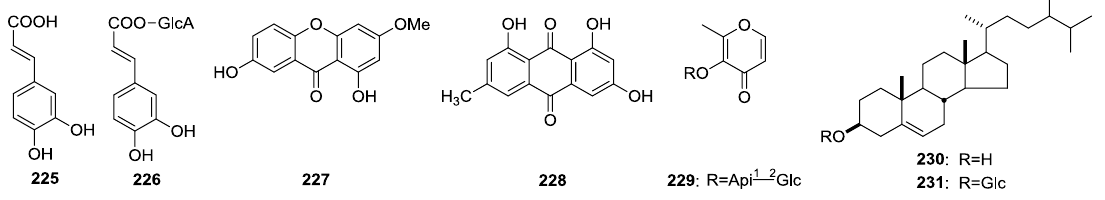
Figure 4. The structures of compounds 225 – 231 obtained from the Astragalus